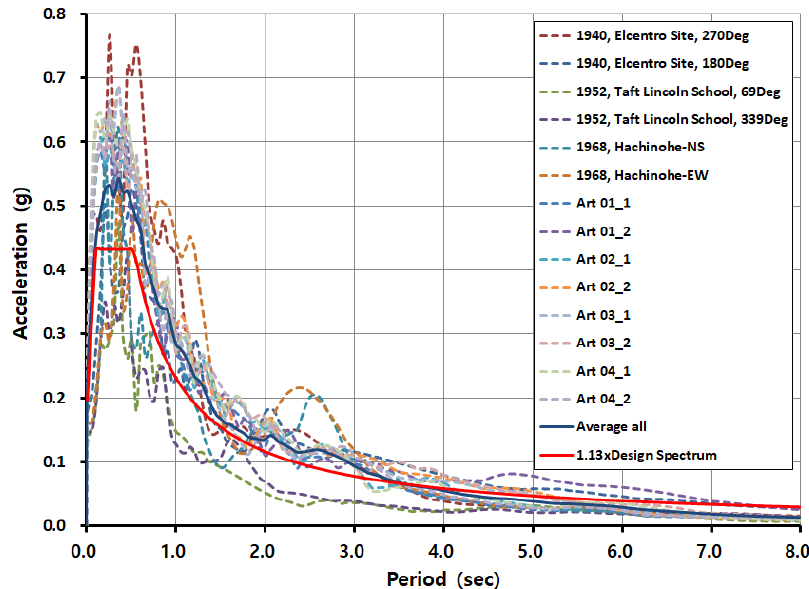
Figure 23. Spectral acceleration responses of the scaled ground accelerations.